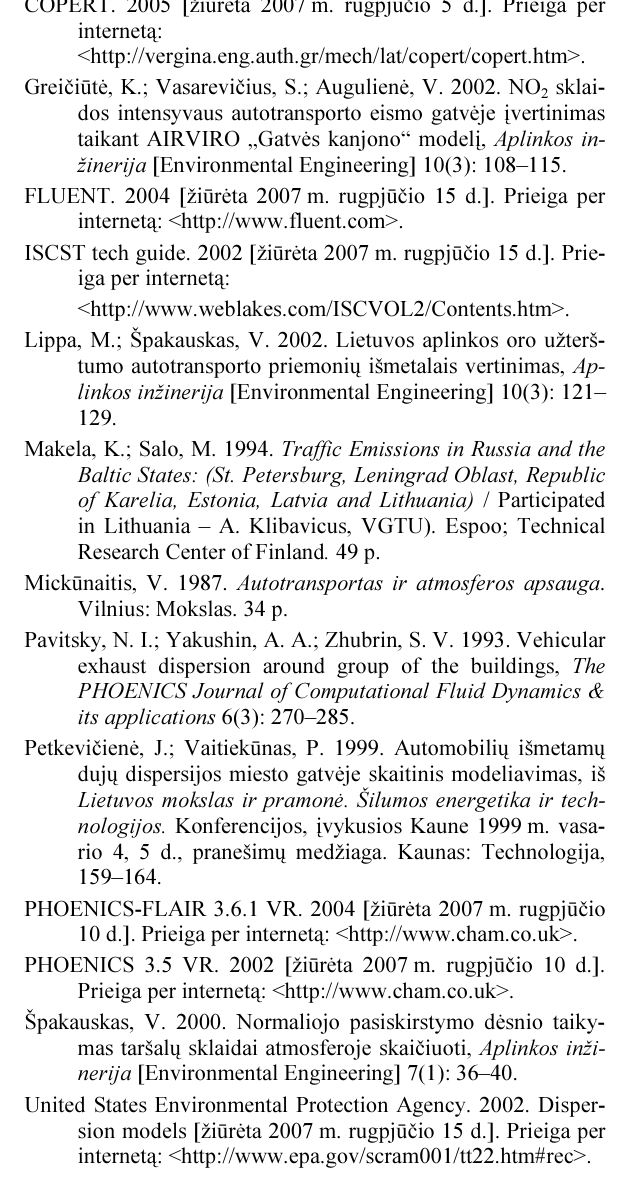
Fig. 15. The modelling results of CO scatter µ g/m (Fig.